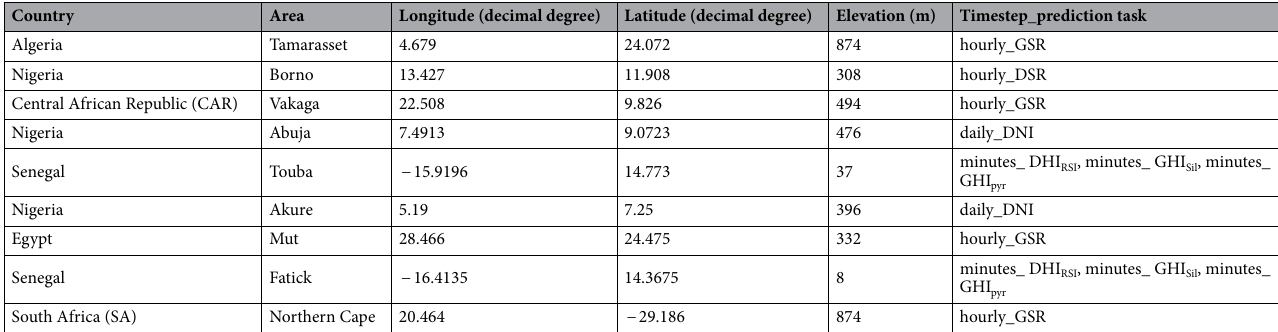
Table 2. Location details of research dataset.